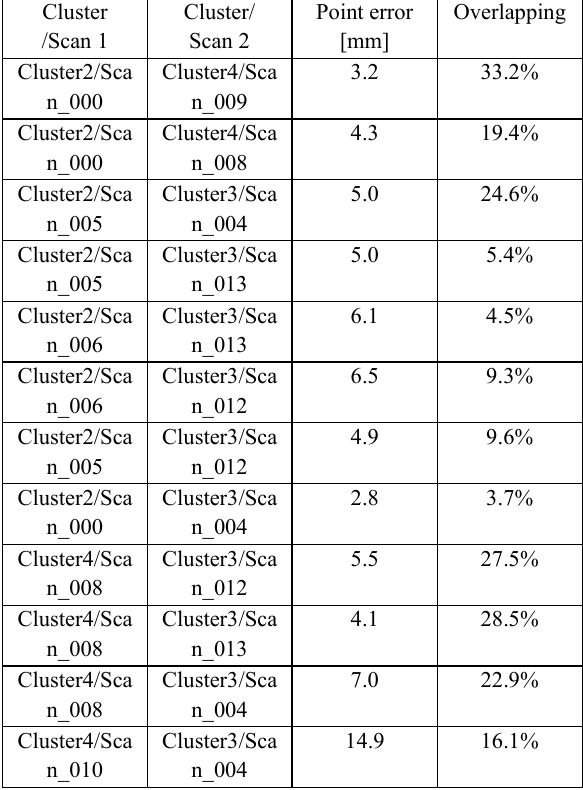
Table 1. Statistics of the TLS acquisition.